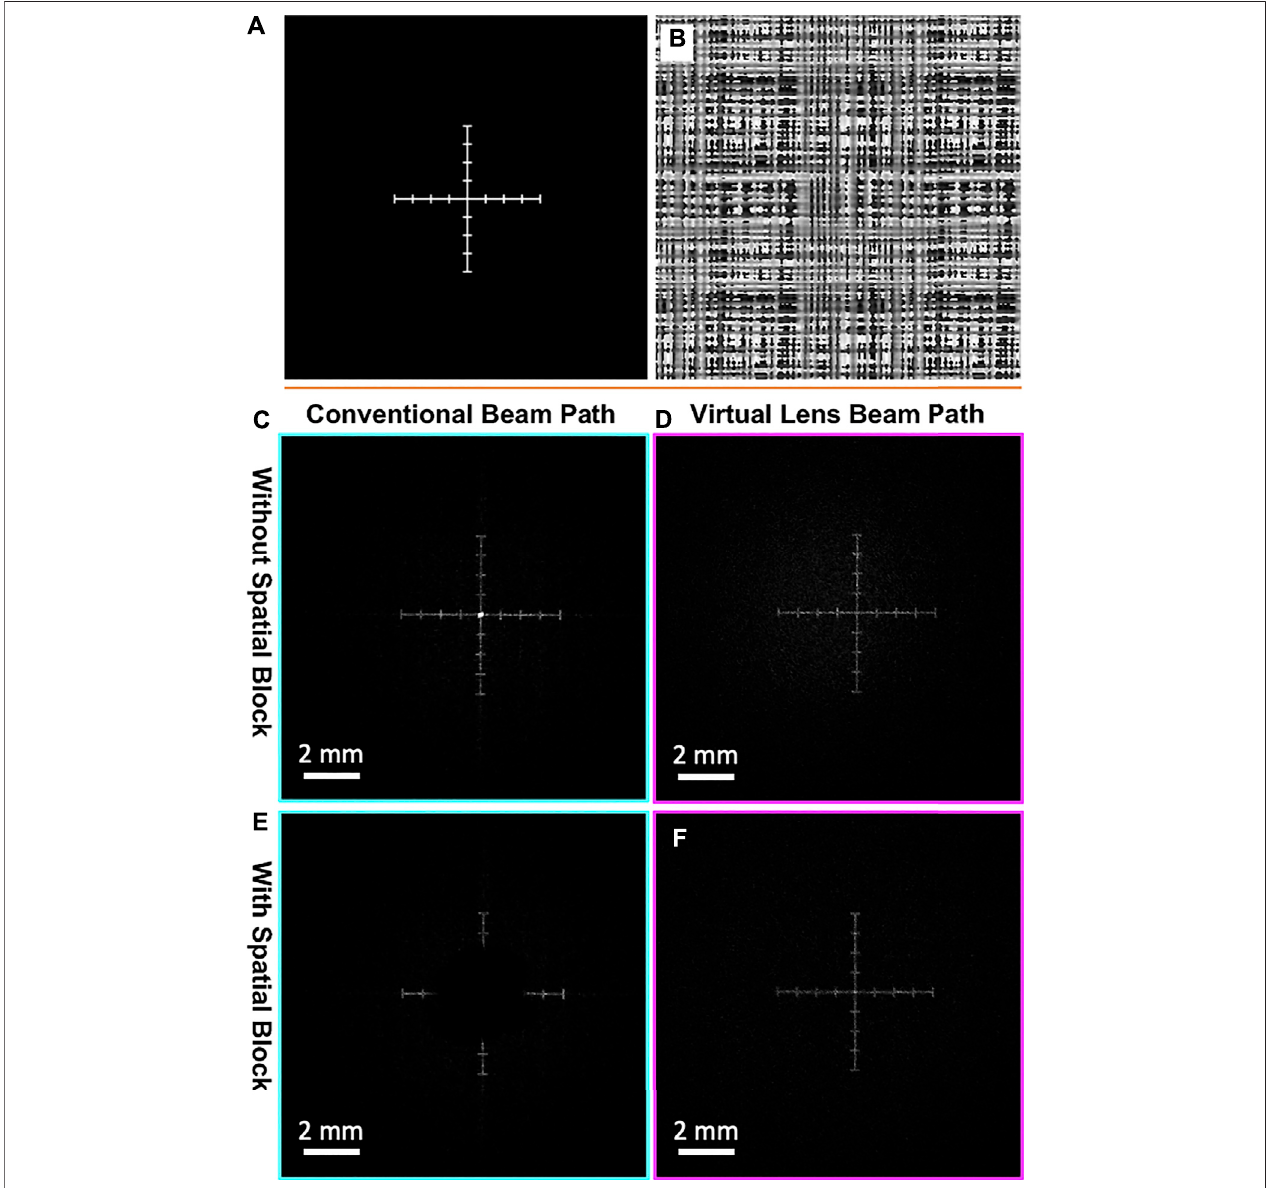
FIGURE 3 | Comparing intensity patterns between conventional and virtual lens beam paths. (A) The target intensity pattern for a Cartesian axis. (B) The corresponding phase mask. (C – F) The resulting intensity patterns seen by the camera in each beam path in the presence or absence of a spatial block for the beam paths. (C) The unmodulated light focuses into a bright central spot in the conventional path without a spatial block. (D) The unmodulated light does not come into focus anywhere after the imaging lens in the virtual lens beam path and creates a very dim Gaussian background intensity. (E) Using a spatial block in the conventional path removes information from the center of the FOV, making it inaccessible for photo-stimulation. (F) Using a spatial block in the virtual lens beam path removes the background Gaussian intensity generated by the unmodulated light, while keeping the entire FOV